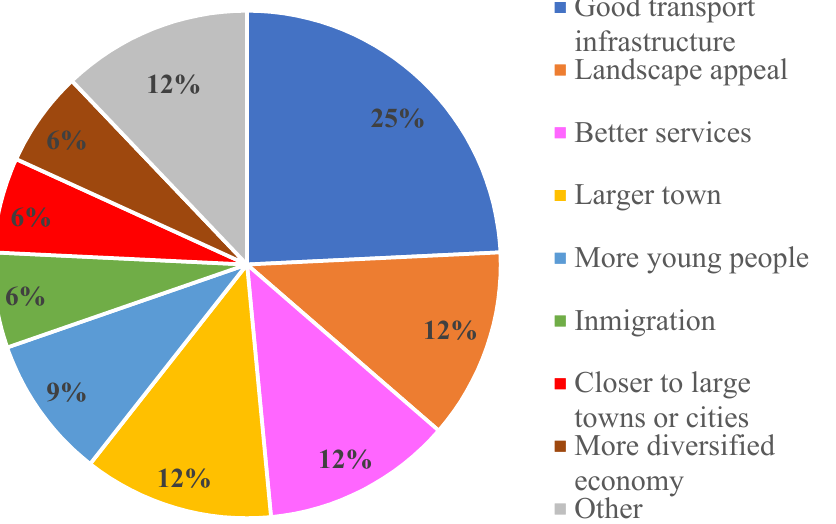
Figure 3. Stated causes for the depopulation figures in the two best performing protected municipalities, according to experts.